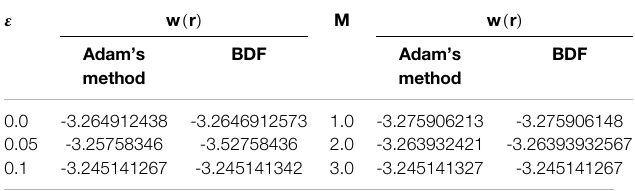
TABLE 5 | Analysis of convergence and complexity assessment for M (cid:1) 1. Numerical technique